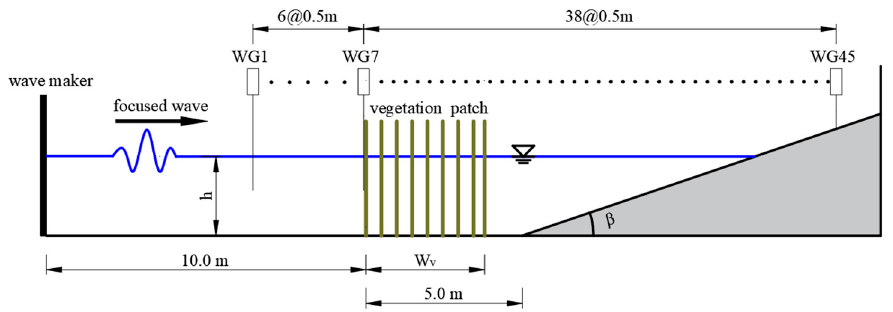
Figure 6. Computational